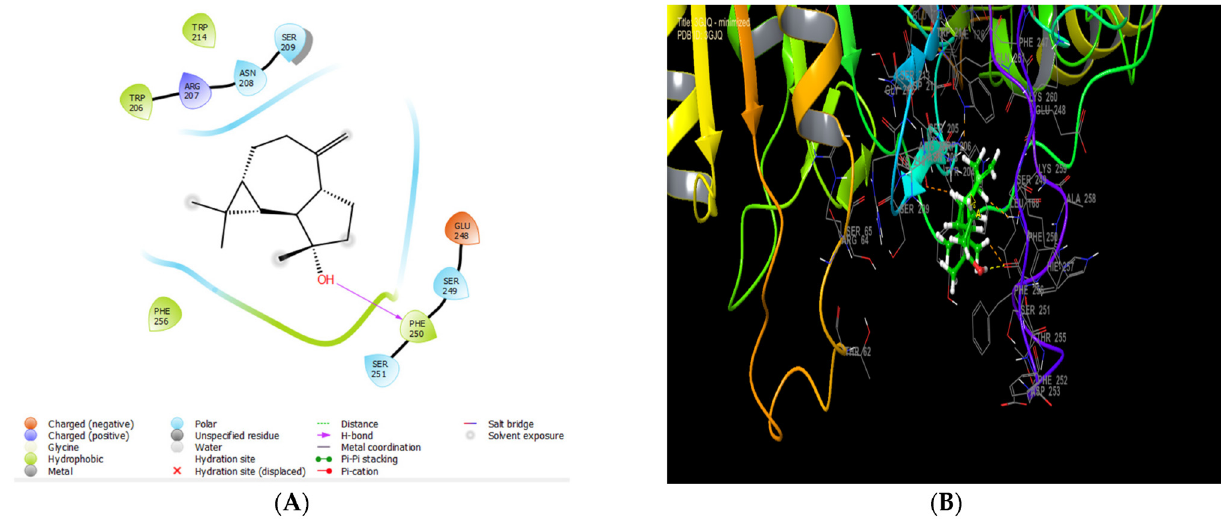
Figure 6. The 2D ( A ) and 3D ( B ) diagrams of the 1H-Cycloprop[e]azulen-7-ol, decahydro-1,1,7-trimethyl-4-methylene-, [1ar-(1a.alpha.,4a.alpha.,7.beta., 7a.beta.,7b.alpha.)]- interactions with the active site of caspase-3 (PDB: 3GJQ). The ligand-caspase glide score energy values were − 5.156 kcal/mol.